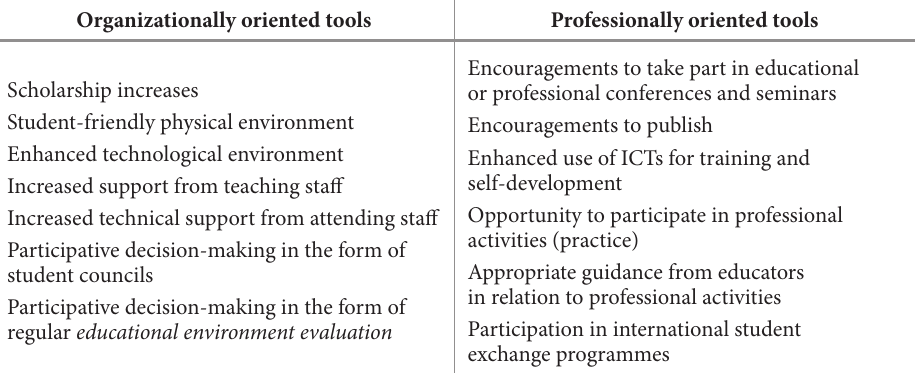
Table 2. The proposed incentives for motivating university students (Adapted from Badawy 2008) Organizationally oriented